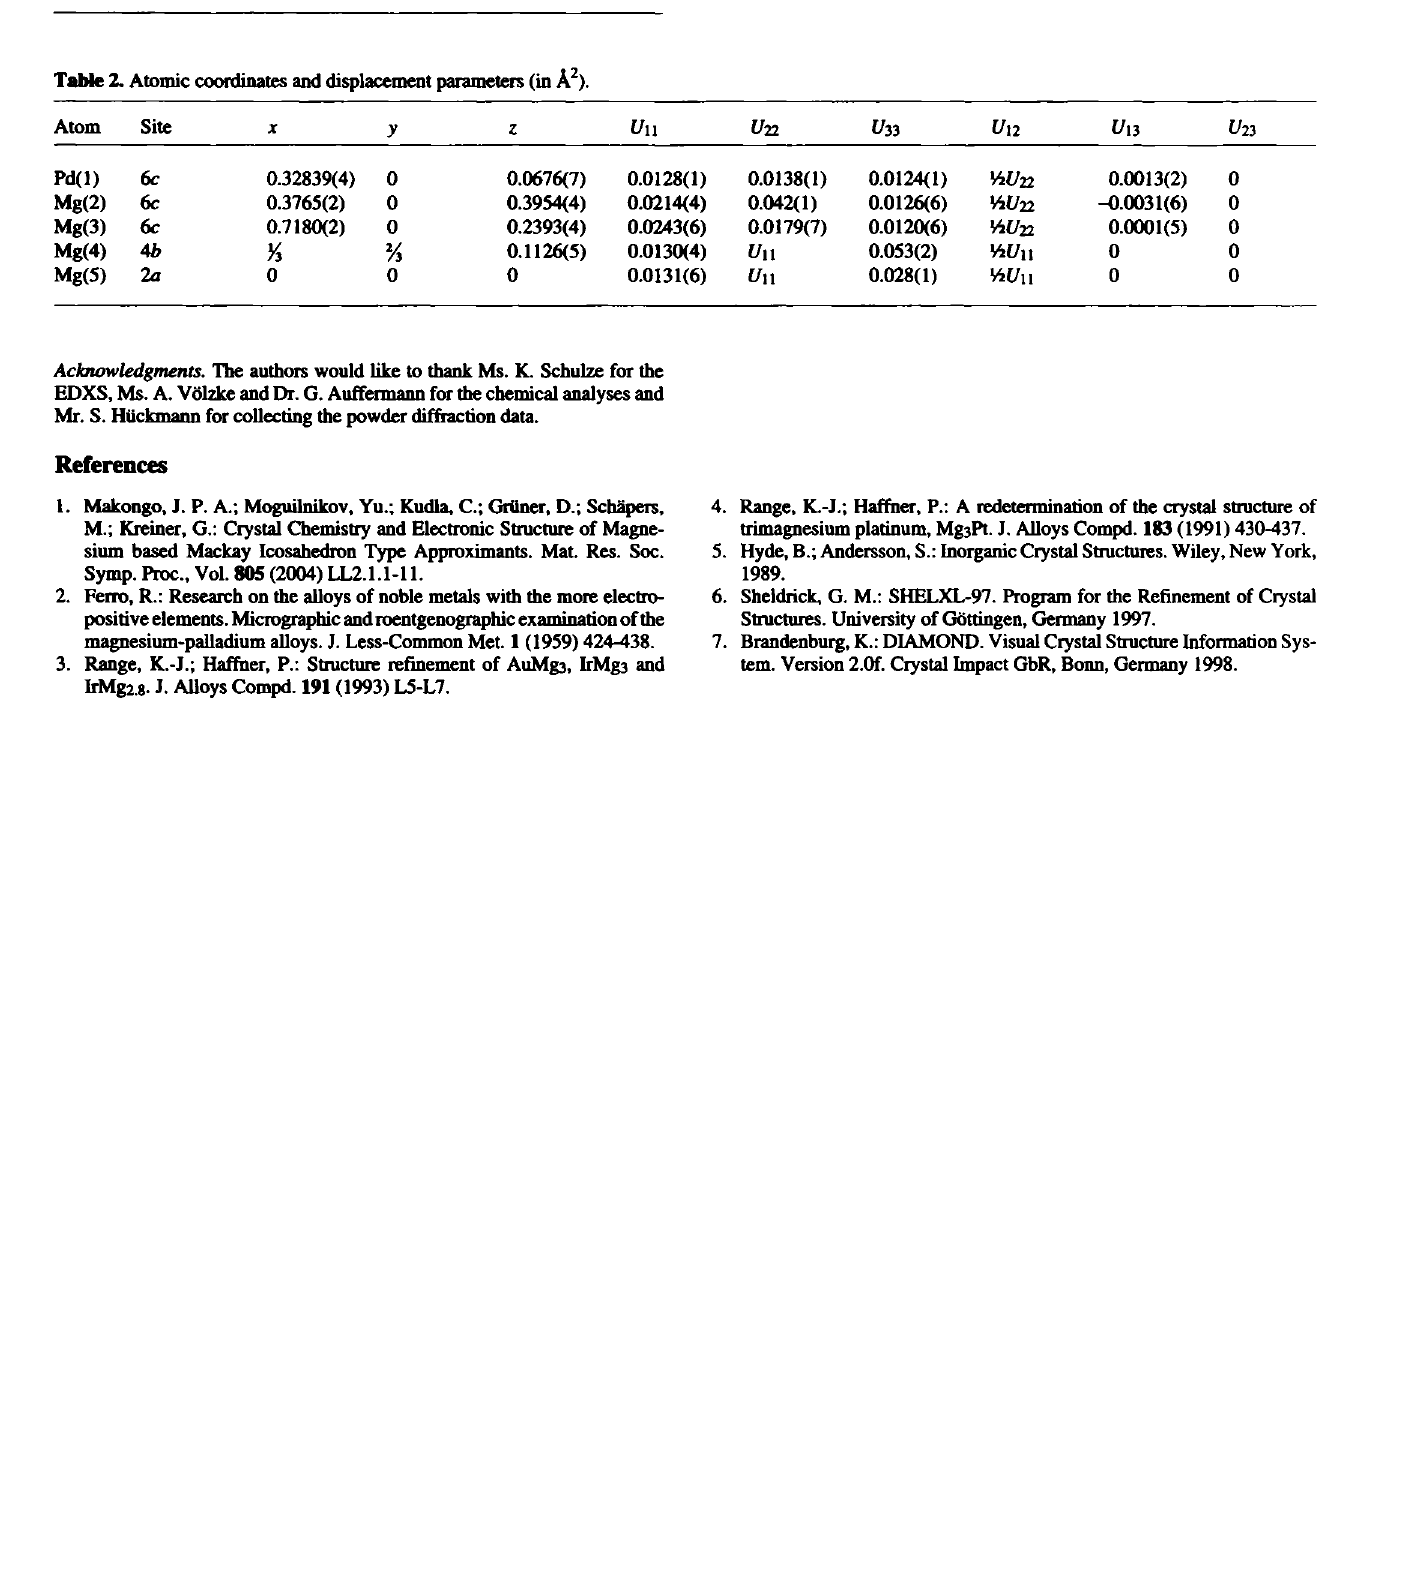
Table 2. Atomic coordinates and displacement parameters (in A 2